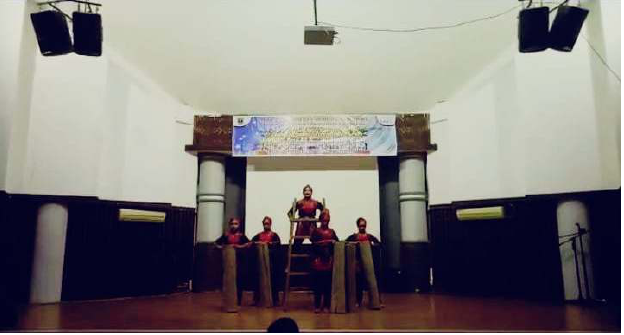
Figure 1. Participants of the Women's Group from SMPN 1 Payakumbuh, received 2nd Place in FLS2N Payakumbuh City (Photo: Hernando Saputra, 2018)